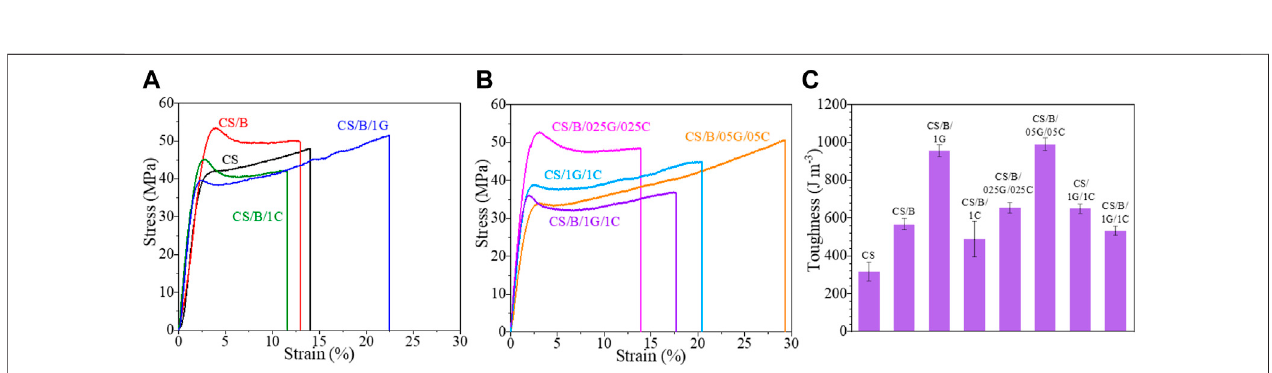
FIGURE 6 | Stress-strain curves of pristine CS and CS-based composite fi lms (A,B) and corresponding toughness values (C) .